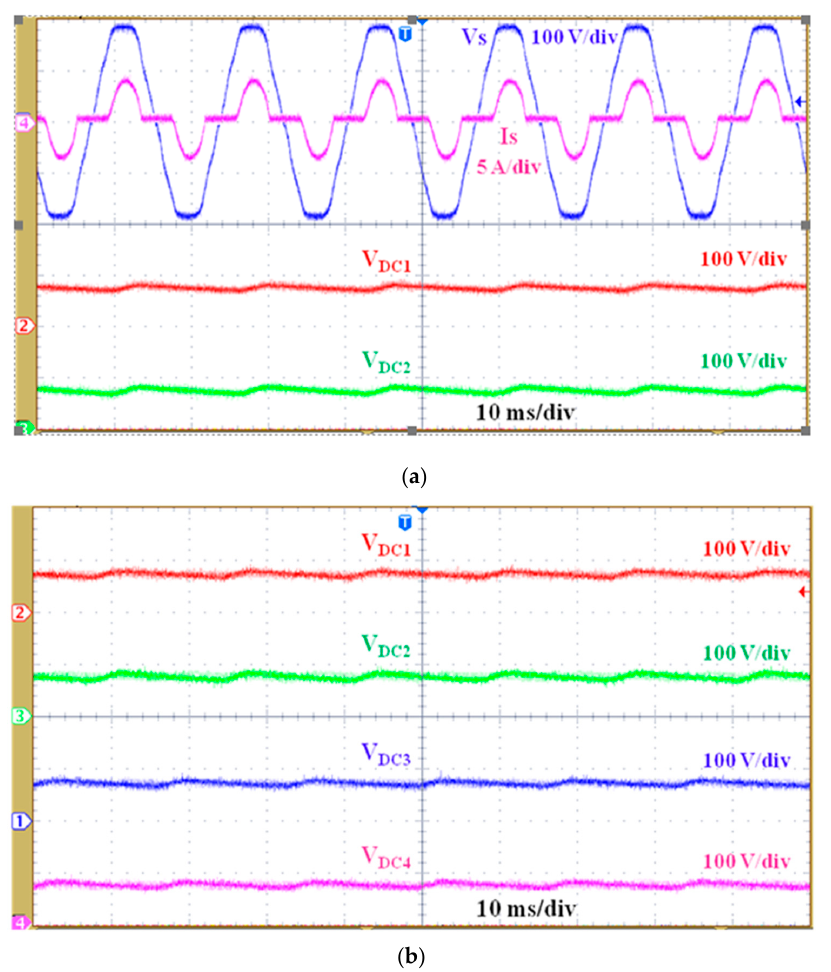
Figure 15. Experimental result for input voltage, input current and dc-link capacitor voltage wave- forms with diode rectifier load. ( a ) Input voltage, input current and two upper dc-link capacitor voltages; ( b ) four dc-link capacitor voltages.